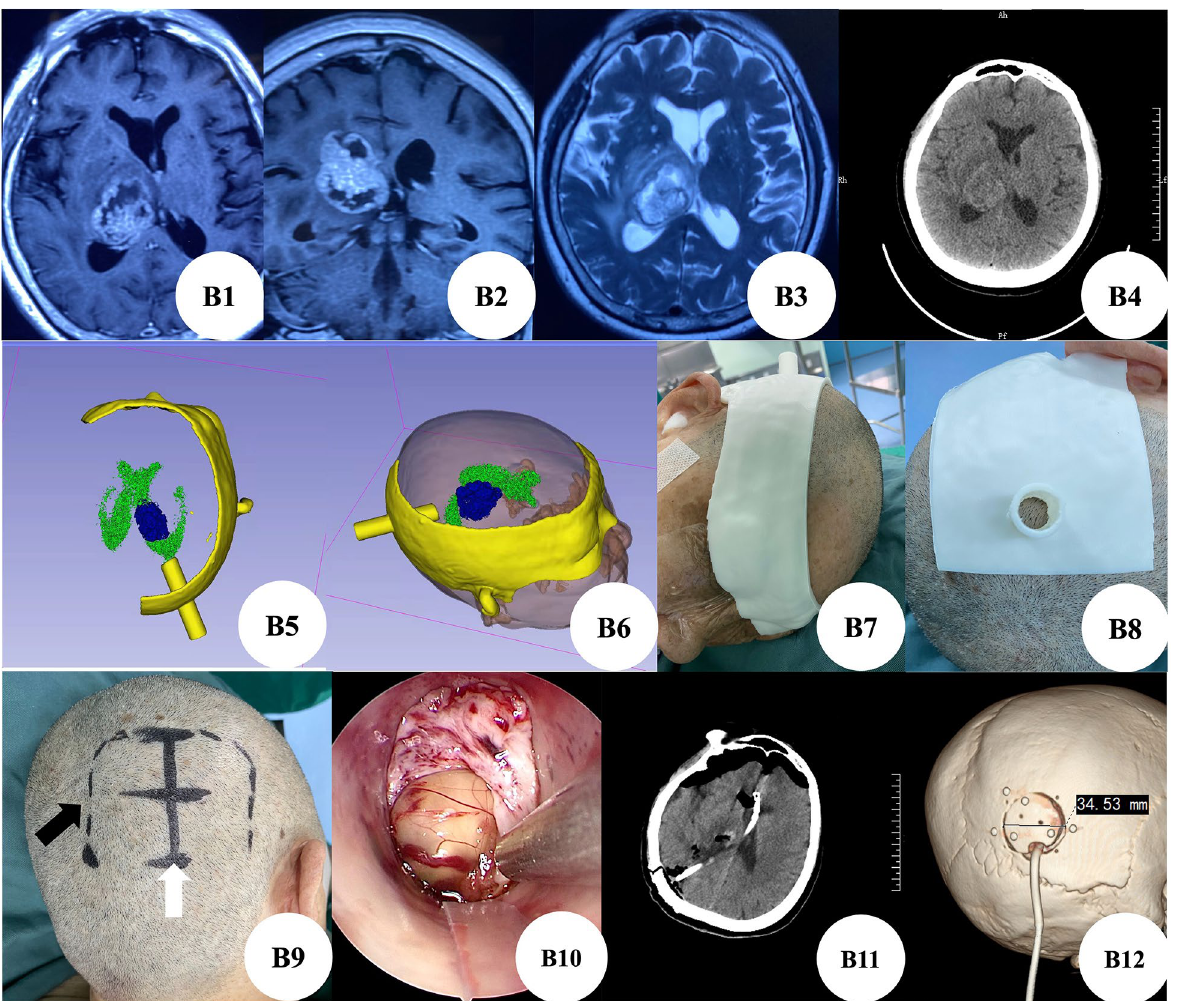
Figure 3. ( B1 – B3 ): Preoperative brain MRI showed space occupying lesions in the right thalamus. ( B4 ): Preoperative brain CT showed space occupying lesions in the right thalamus. ( B5 – B6 ): 3D-Slicer reconstructed the relationship between the lesion and lateral ventricle and positioned the three-dimensional image of the guide plate. ( B7 – B8 ): 3D printing positioning guide. B9 : The straight surgical incision (white arrow) is designed according to the printed positioning guide plate, and the black arrow is the conventional surgical incision. ( B10 ): Lesions under transcranial neuroendoscopic. ( B11 ): Postoperative brain CT showed that the lesion was resected completely. ( B12 ): The three-dimensional reconstruction of the skull showed that the size of the bone window was about 3.5